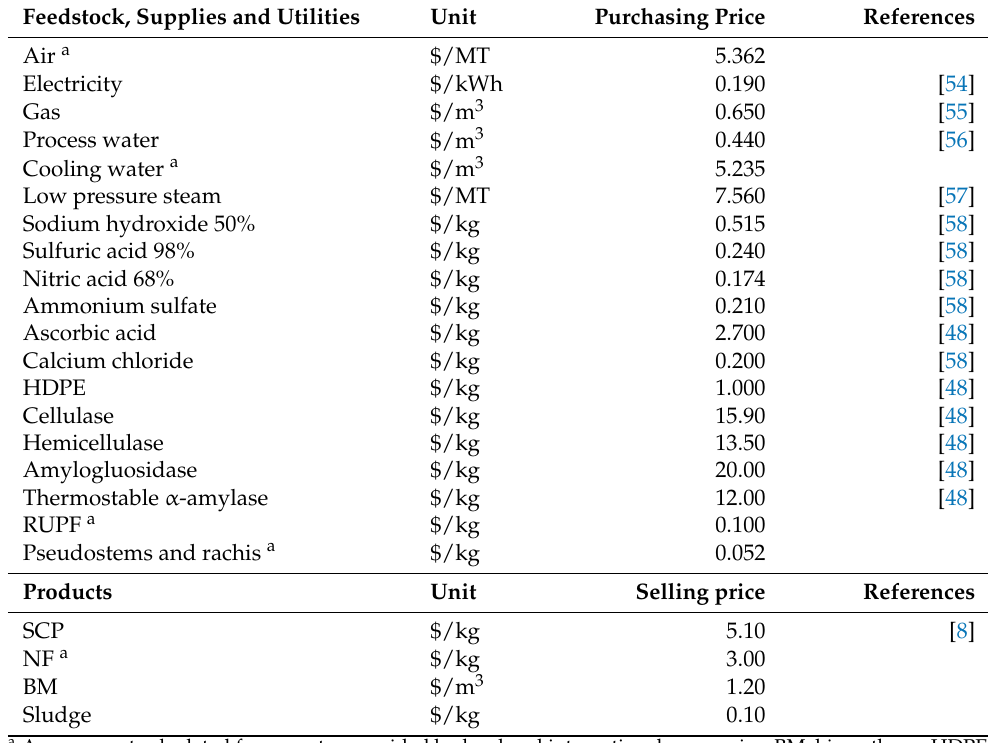
Table 4. Feedstock cost and selling price of products for 2020 used for the techno-economic assessment of the simulated process flowsheets.